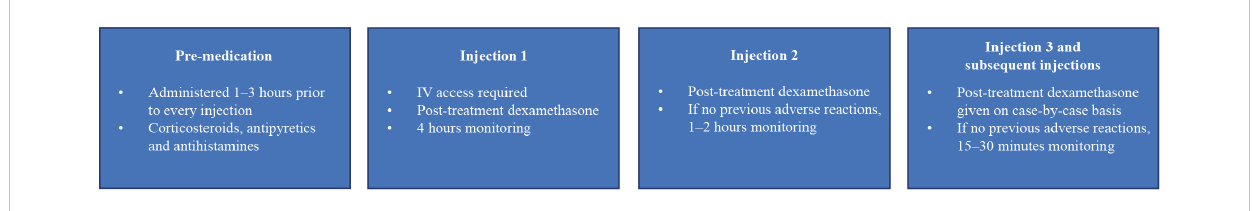
FIGURE 1 Recommendations for pre-medication, administration and post-administration monitoring of SC DARA. DARA, daratumumab; IV, intravenous; SC,